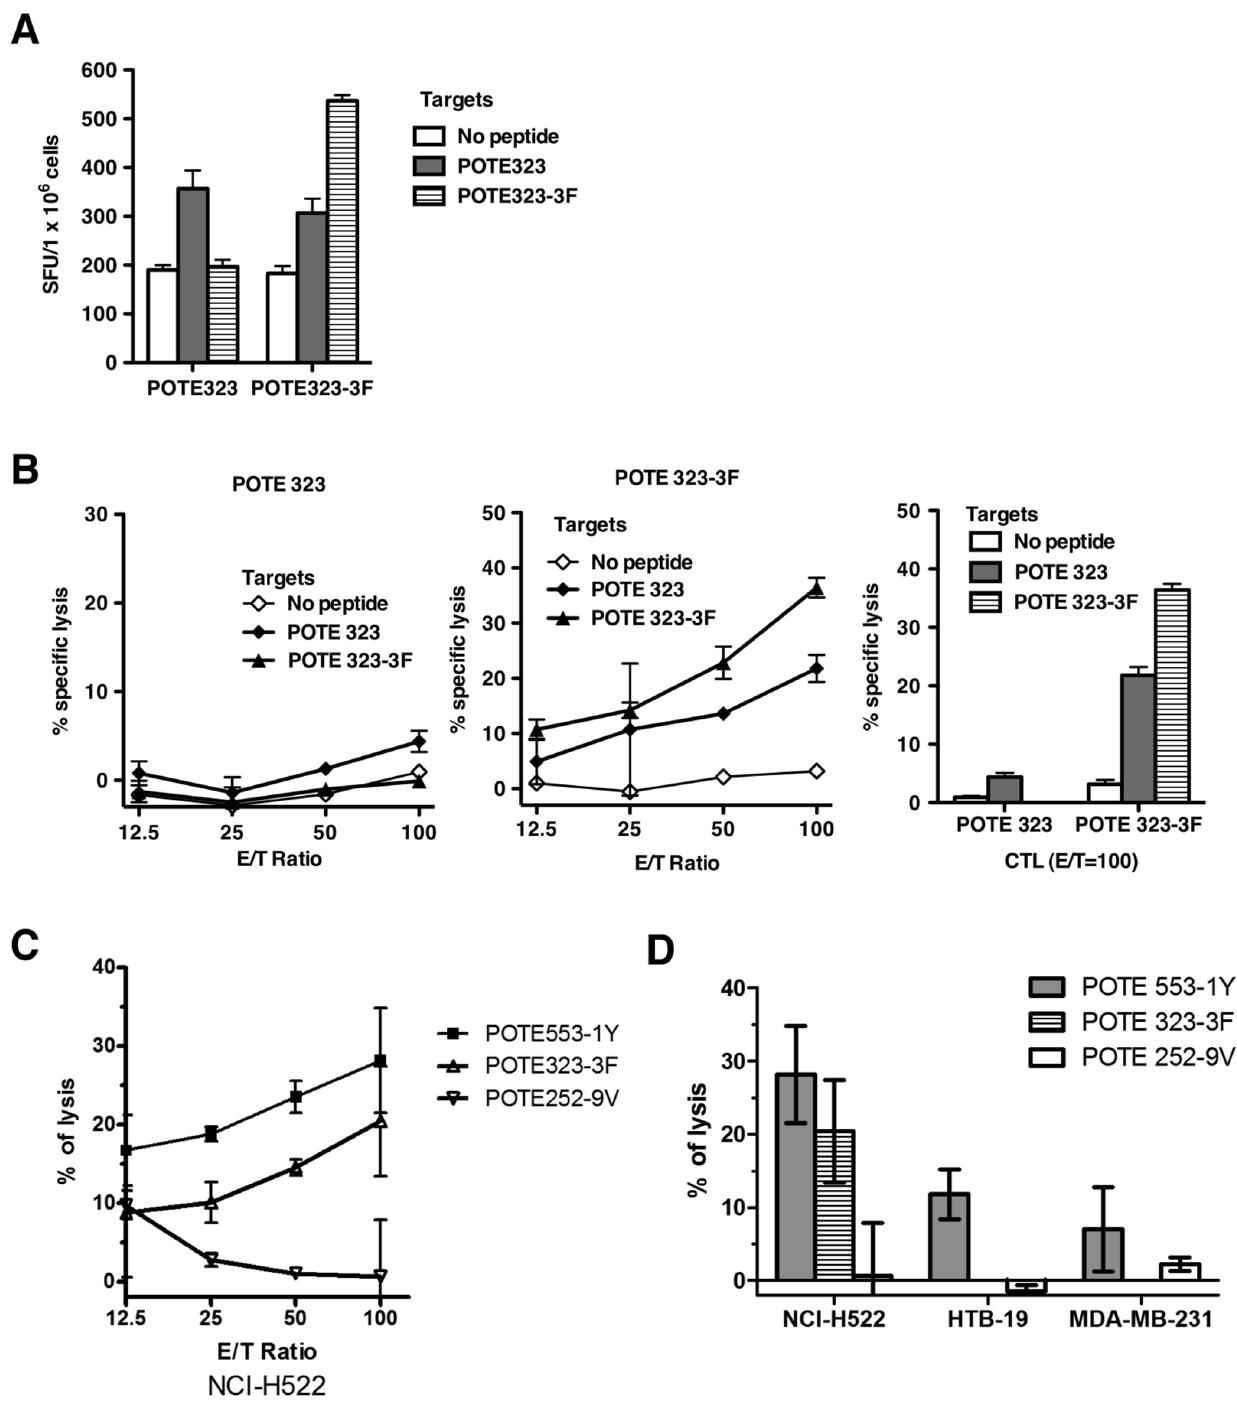
Figure 4. Immunogenicity of the wild-type and enhanced POTE323 epitopes and anti-tumor cytotoxicity induced by enhanced epitopes. AAD mice were immunized s.c. with 50 nmol of peptide in 100 m l of emulsion as described in the Methods section. (A) Direct ex vivo IFN- c ELISPOT assay using target cells pulsed with 1000 nM peptide. Figures show numbers of spots per million cells. (B) CTL cross-reactivity on POTE 323 and POTE 323-3F peptides. (C) Anti-tumor cytotoxicity against a POTE-expressing human lung cancer cell line NCI-H522 induced by POTE 553-1Y, 323- 3F and 252-9V. HHD-2 mice were immunized with 50 nmol of the peptide indicated in 100 m l of emulsion and restimulated for 7 days with 1000 nM peptide before being tested for ability to lyse the tumor cells. (D) Summary of the anti-tumor cytotoxicity in POTE-expressing and non-POTE- expressing human tumor cells. NCI-H522 is a human lung cancer line expressing both POTE and HLA-A2, whereas HTB-19 is a human mammary carcinoma that expresses POTE but not HLA-A2, and MDA-MB-231 is a human mammary carcinoma cell line expressing HLA-A2 but not POTE. Killing of only the first of these shows the specificity for POTE in combination with HLA-A2. (Negative values are due to experimental 51 Cr release slightly below spontaneous release with no effector cells, within experimental error, and so should be viewed as equivalent to zero).